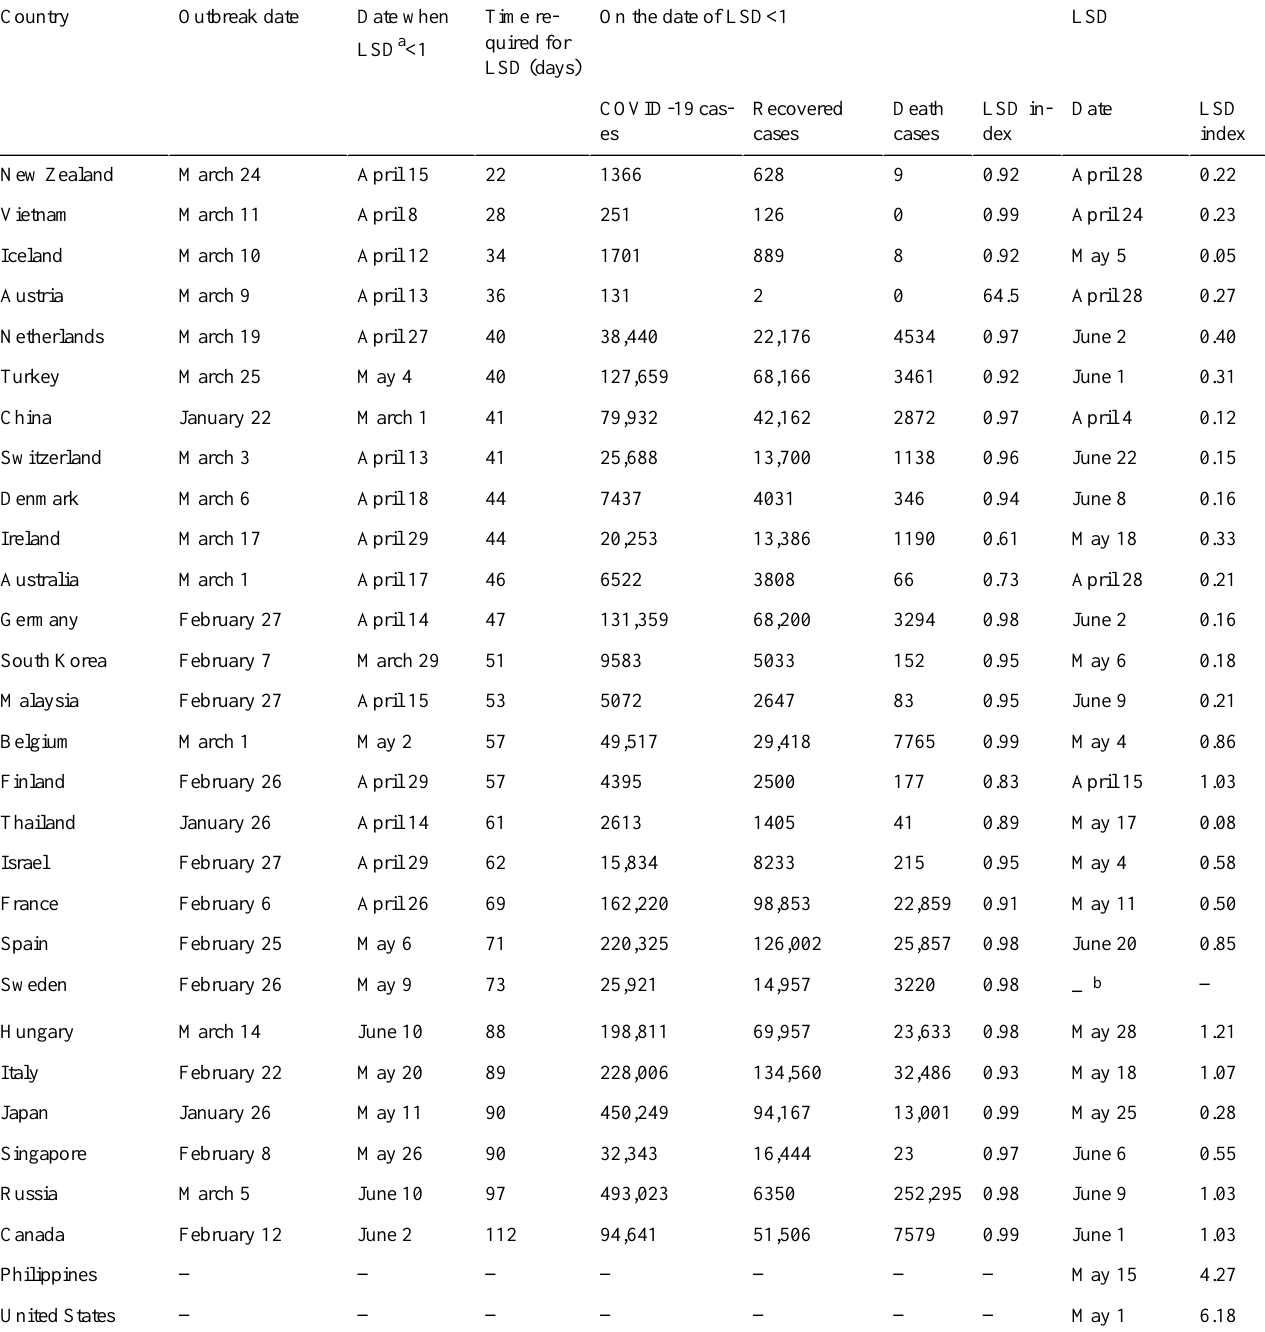
Table 1. Time required and LSD index for LSD in selected countries.